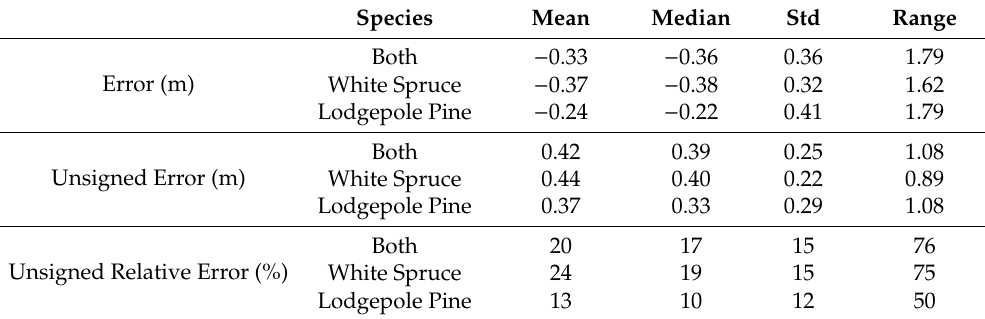
Table 8. Descriptive statistics for each error type. While the mean and median values of lodgepole pine are more desirable than those of white spruce, the lodgepole pine error distributions are less consistent with the exception of unsigned relative